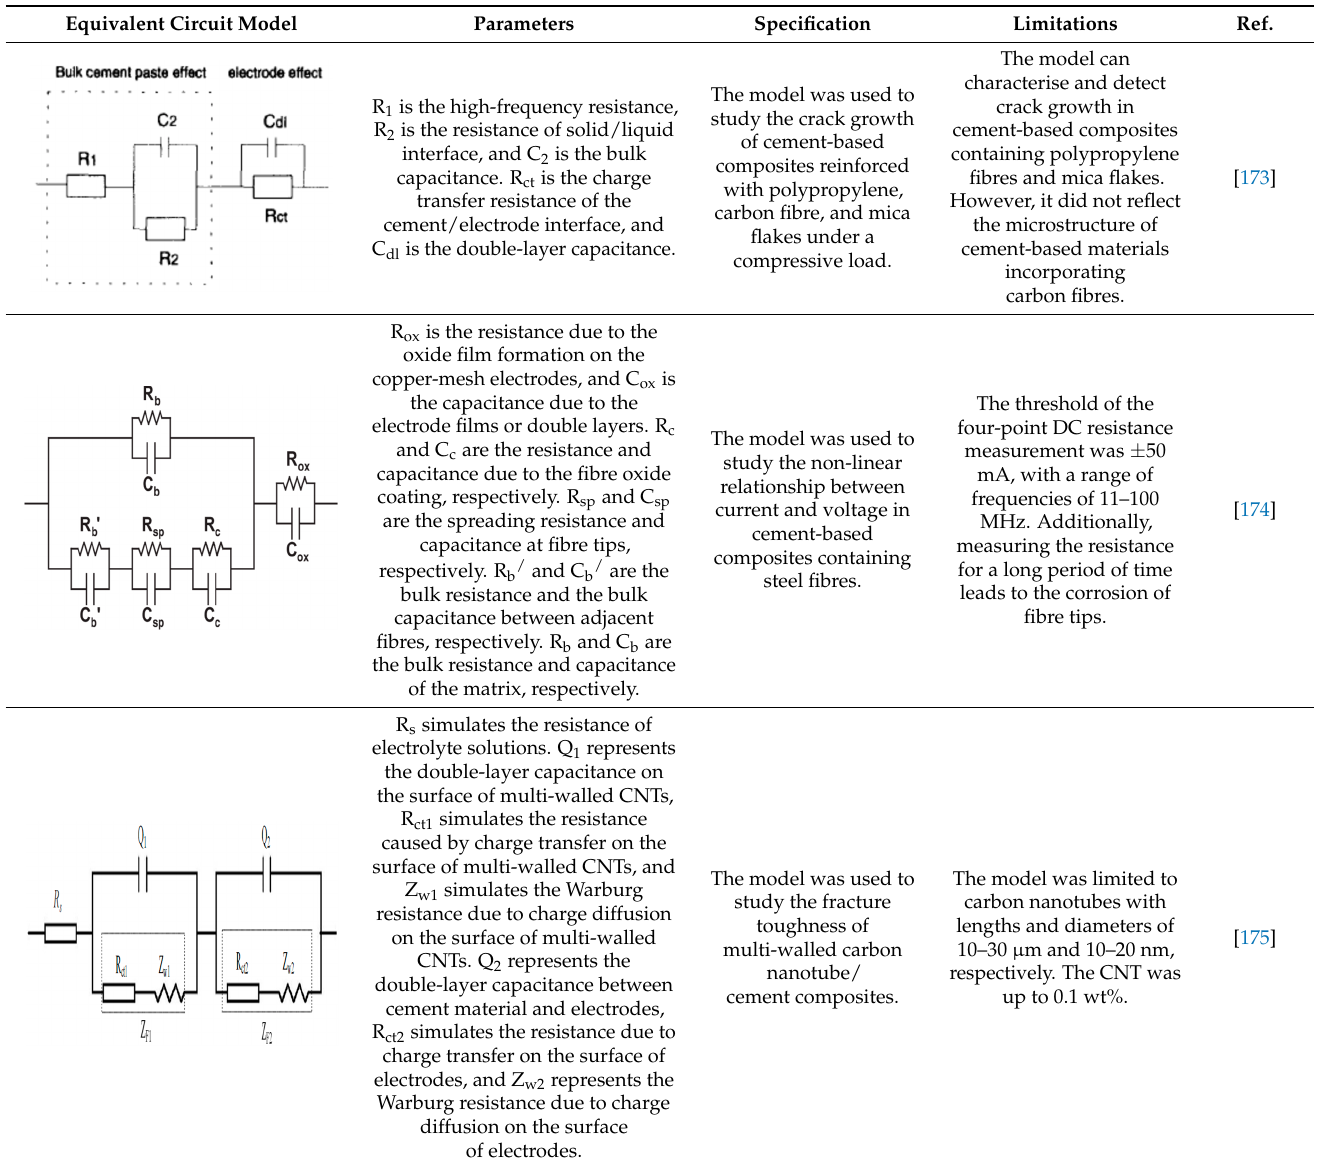
Table 4. Summary of equivalent circuit models related to different cement-based sensors.